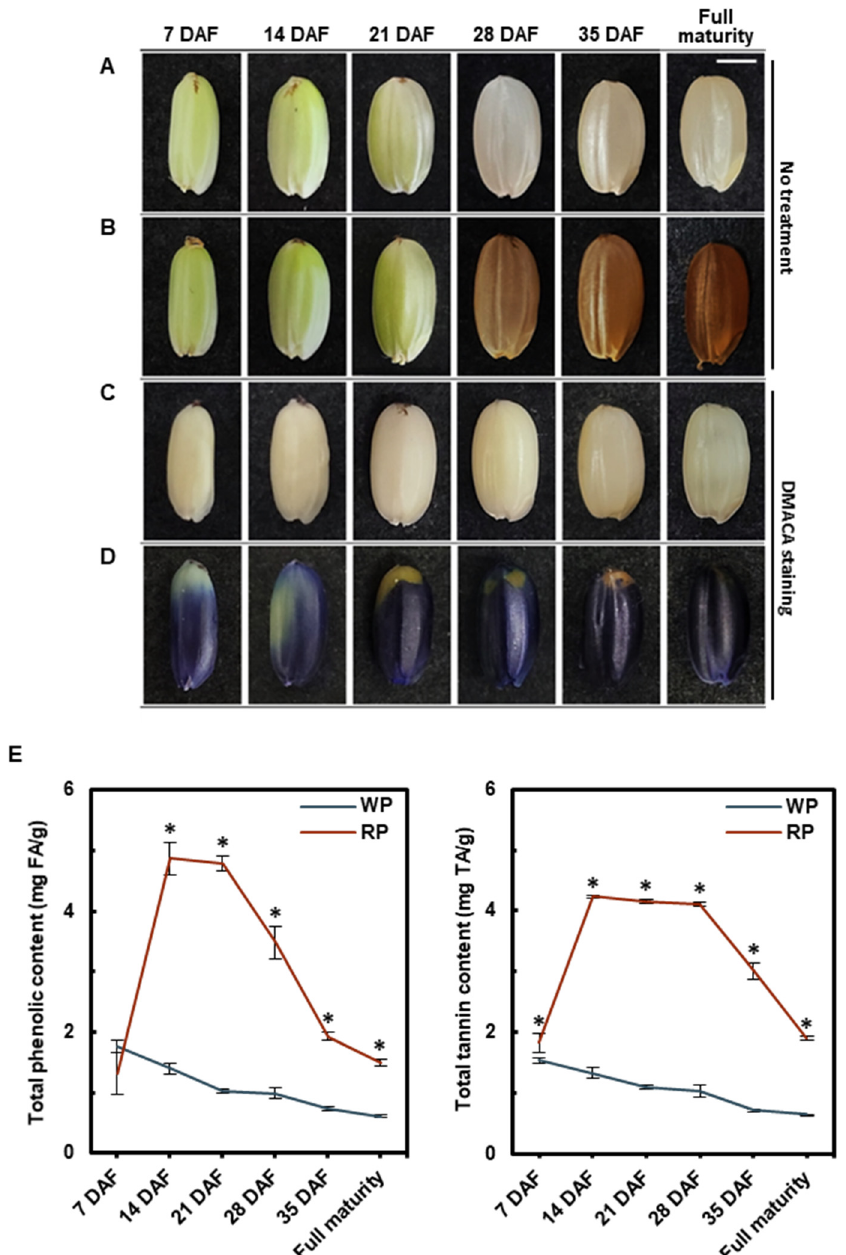
Figure 1. Comparison of grain characteristics between red pericarp (RP) and white pericarp (WP) rice. Pericarp color of WP ( A ) and RP ( B ) rice according to seed development. Pericarp color changes in WP ( C ) and RP ( D ) rice after 4-dimethyl aminocinnamaldehyde (DMACA) staining. Scale bar: 2 mm. ( E ) Quantitative analysis of total phenolic content and total tannin content in seeds of WP and RP rice during seed development. Error bars represent the standard deviation of three replicates. Asterisks denote significant differences according to Student’s t -test ( p < 0.05). FA, ferulic acid; TA, tannin acid.